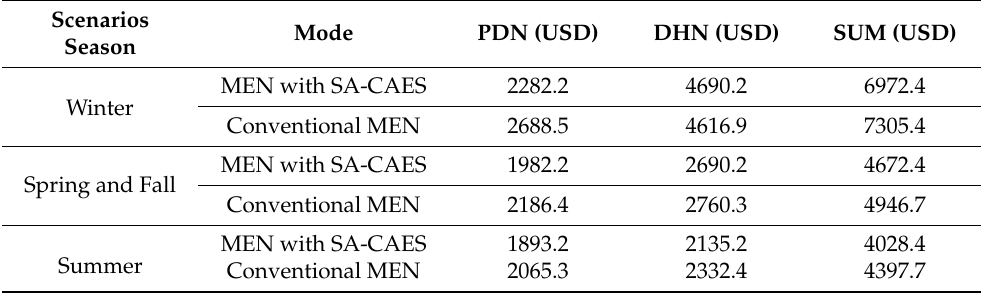
Table 4. Operation costs under the MEN with and without the SA-CAES for different seasonal scenarios.